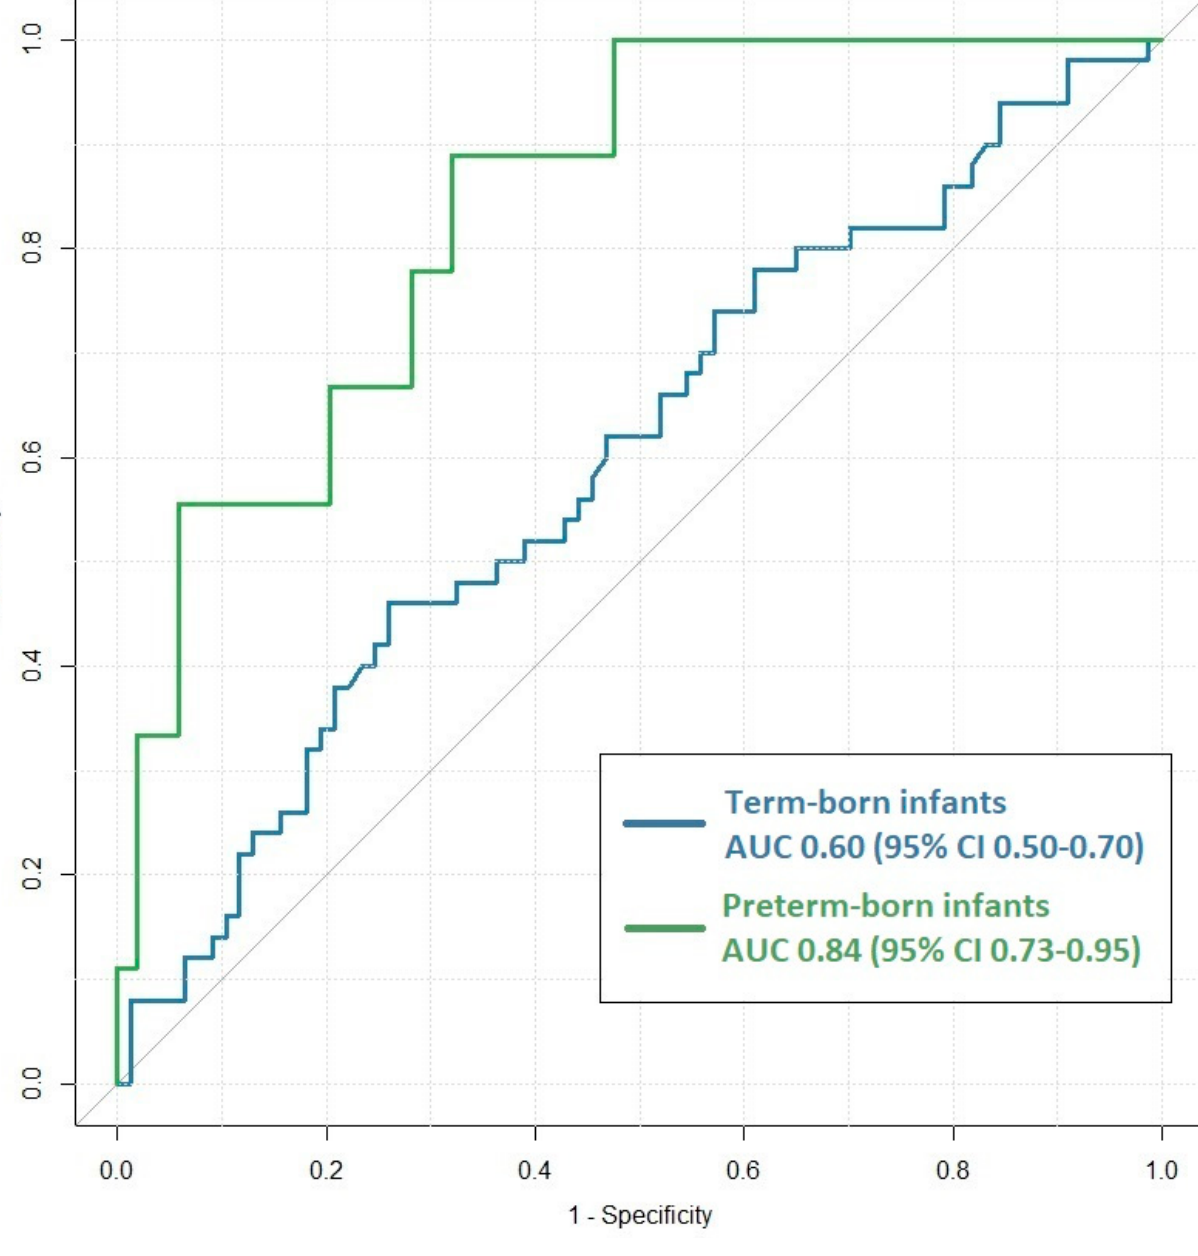
Figure 2. Receiver-operating characteristic (ROC) curves for presepsin concentrations before antibiotic initiation at initial sepsis suspicion (t = 0) differentiating between early-onset neonatal sepsis cases and uninfected controls in term-born infants (blue) and preterm-born infants (green). Area under the curve (AUC) values were 0.60 (95% CI: 0.50–0.70) and 0.84 (95% CI: 0.73–0.95), respectively.